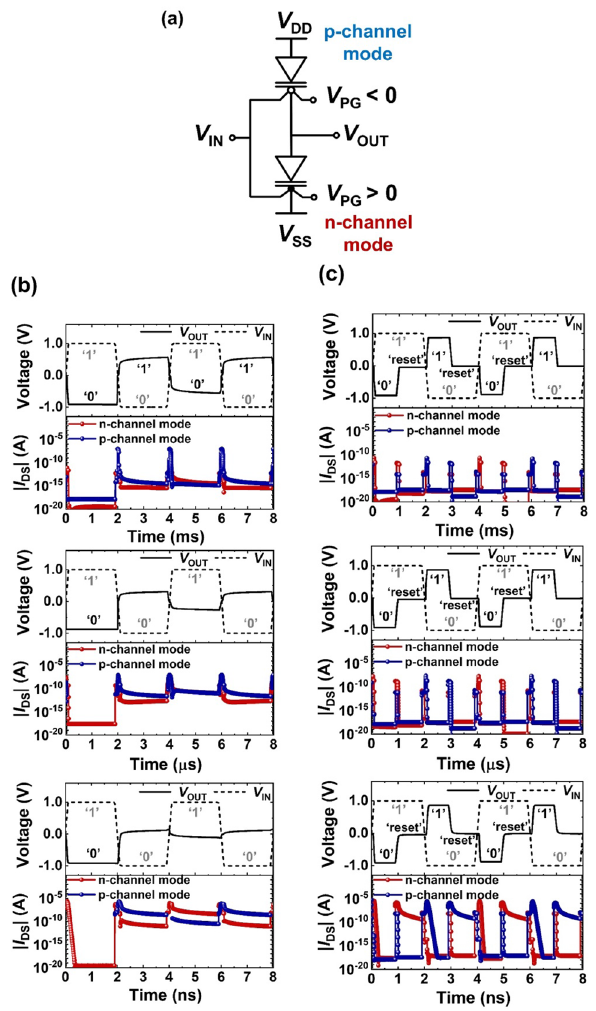
Figure 2. ( a ) Schematic of the inverter comprising the reconfigurable DG FBFETs. ( b ) Timing diagrams of the non-full swing inverting logic operation with ms, μs, and ns time steps under static conditions (a V DD of 1.0 V, a V SS of −1.0 V, and a | V PG | of 1.0 V). ( c ) Timing diagrams of the full swing inverting logic and reset operations with ms, μs, and ns time steps. The reset operation between the logic operations is carried out to eliminate the accumulated charge carriers; the reset operation takes place with V IN = 1.0 V and V PG = V DD = V SS = 0.0 V for the output logic ‘0’, and V IN = −1.0 V and V PG = V DD = V SS = 0.0 V for the output logic